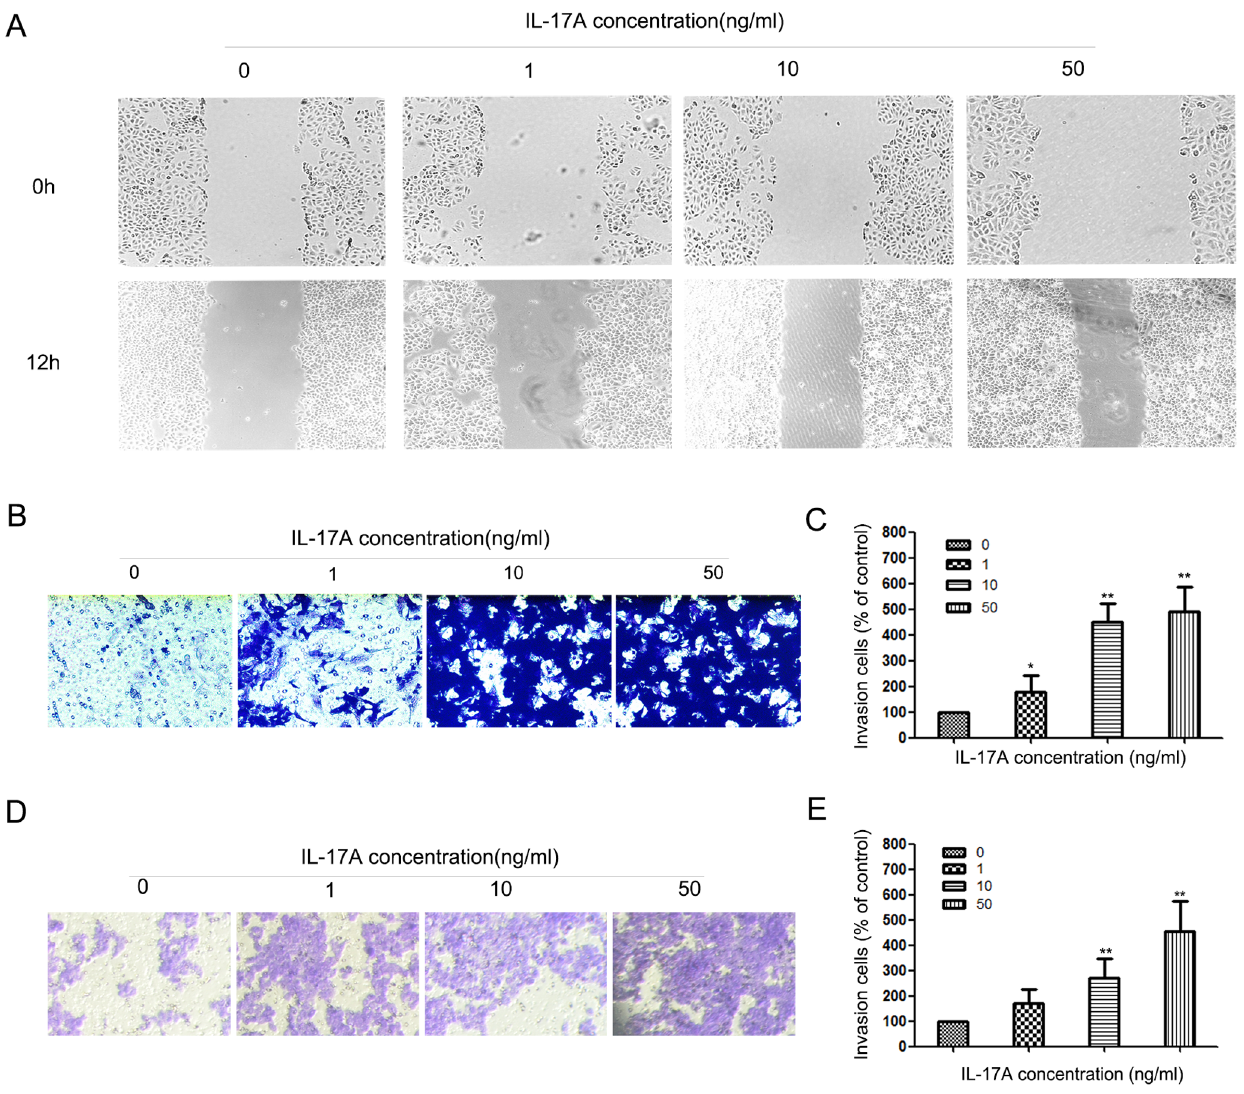
Figure 1. IL-17A promotes NPC cell migration and invasion. (A) IL-17A treated NPC-039 cells showed higher motility in a wound-healing assay, compared with cells without IL-17A treatment. (B) Effect of IL-17A on NPC-039 cells invasion was detected by transwell assay. Representatives of cells migrated through Matrigel-coated transwell were shown. (C) Total invasive cell number in each chamber was summarized as a percentage of control. (D) Effect of IL-17A on CNE-2Z cells invasion was detected by transwell assay. Representatives of cells migrated through Matrigel-coated transwell were shown. (E) Total invasive cell number in each chamber was summarized as a percentage of control. Values represent the means 6 SD of three independent experiments performed in triplicate. * p , 0.05 and ** p , 0.01 compared with the control